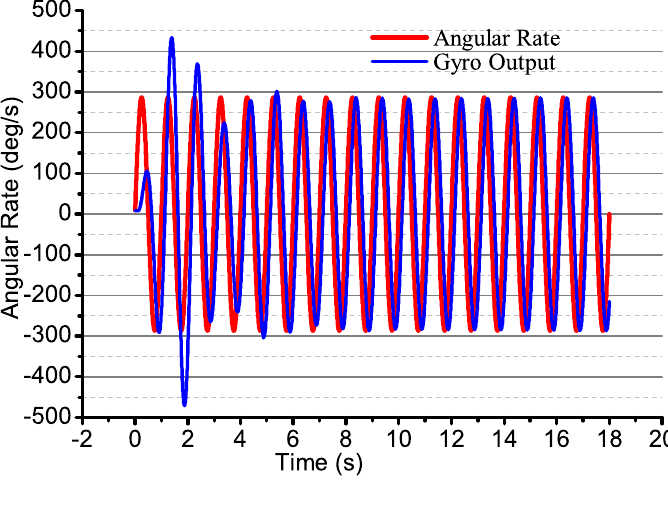
Figure 23. The calculated angular rate output with control in Ω is square.